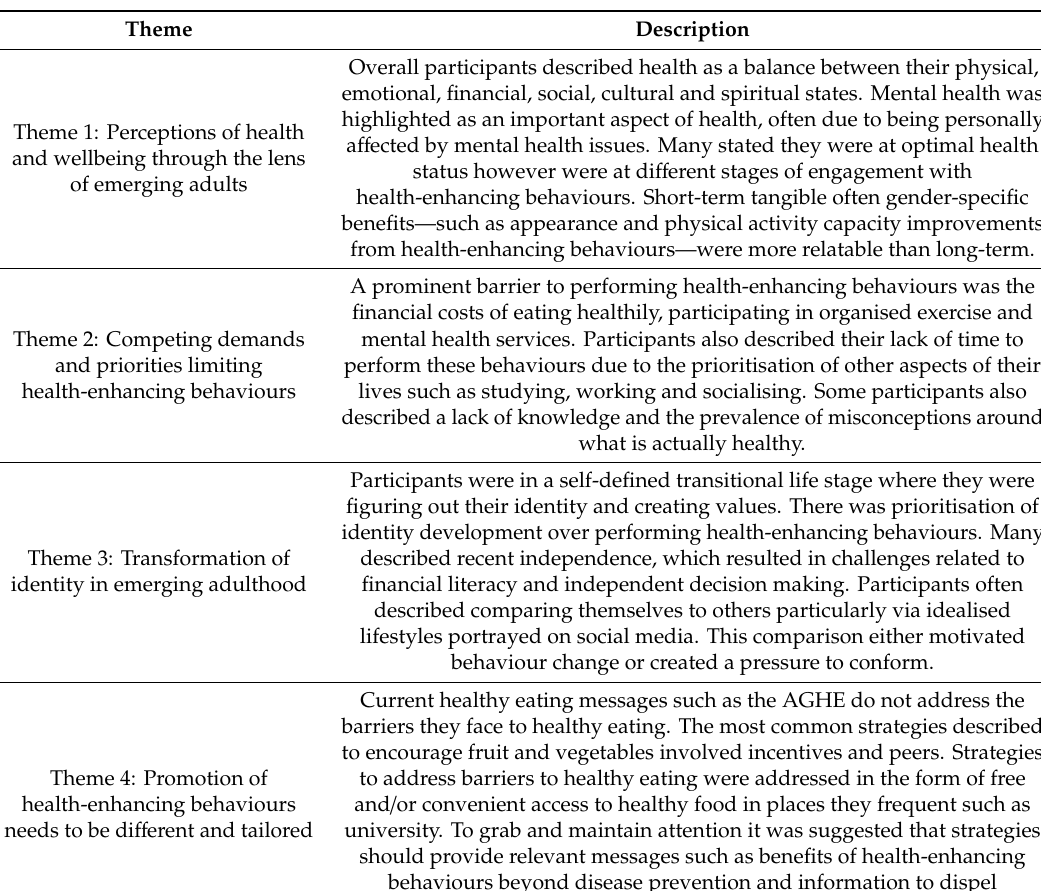
Table 3. Themes and brief descriptions from analysis of complete data